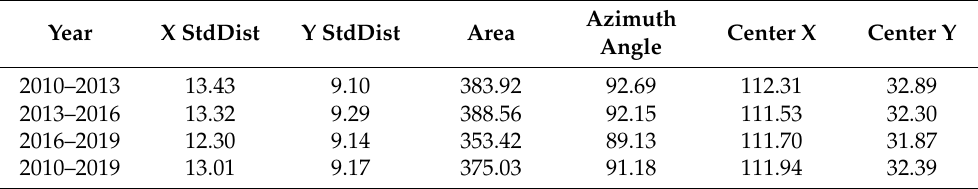
Table 3. Parameters of weighted standard deviation ellipse of industrial